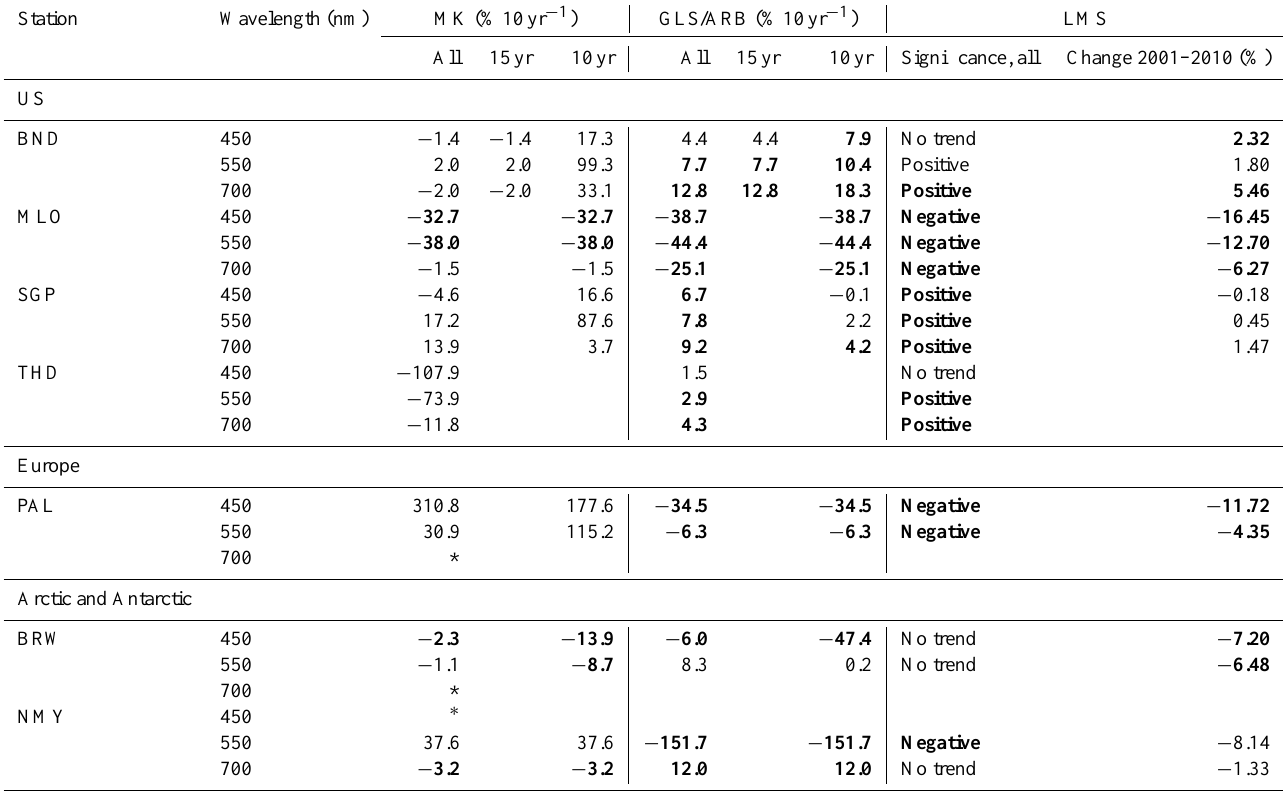
Table 6. Significance and slope of the trends of the backscatter fraction; the labels are similar to Table 3. Station